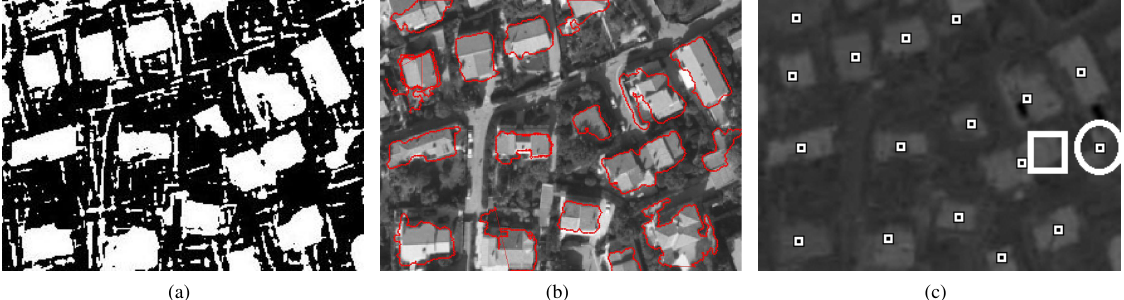
Figure 3: Steps of multidirectional building detection: (a) is the connectivity map; (b) shows the detected building contours in red; (c): marks the estimated location (center of the outlined area) of the detected buildings, the falsely detected object is marked with a white circle, missed object is marked with a white rectangle.